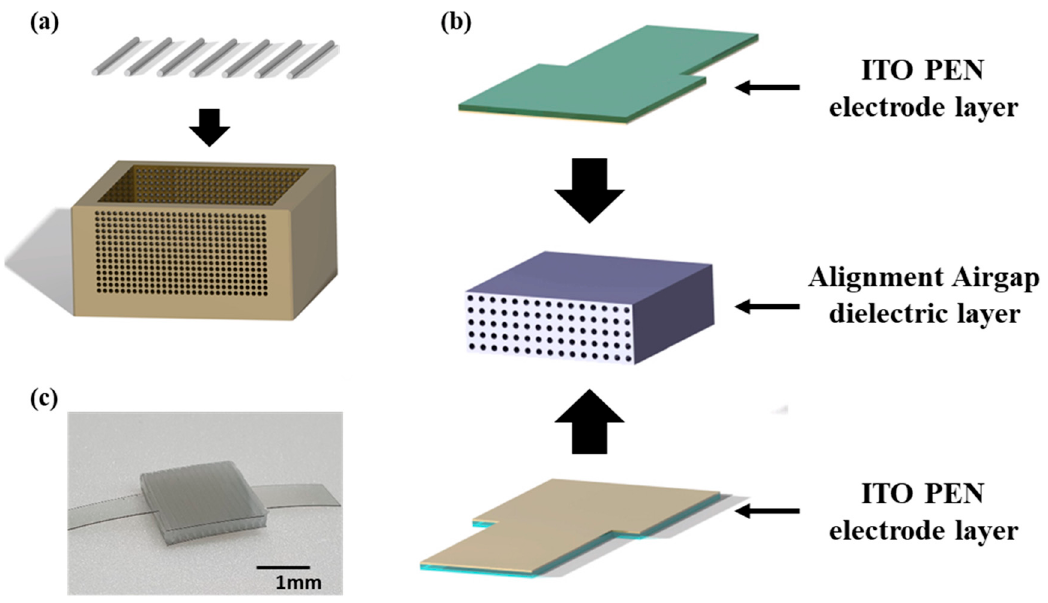
Figure 1. Fabrication process and structure of the device. ( a ) Schematic diagram of the micro-needles and mold for the alignment airgap structure. ( b ) Schematic diagram of the flexible ITO PEN film electrodes (top and bottom) and the alignment airgap dielectric layer (middle). ( c ) Photograph of the capacitive pressure sensor.